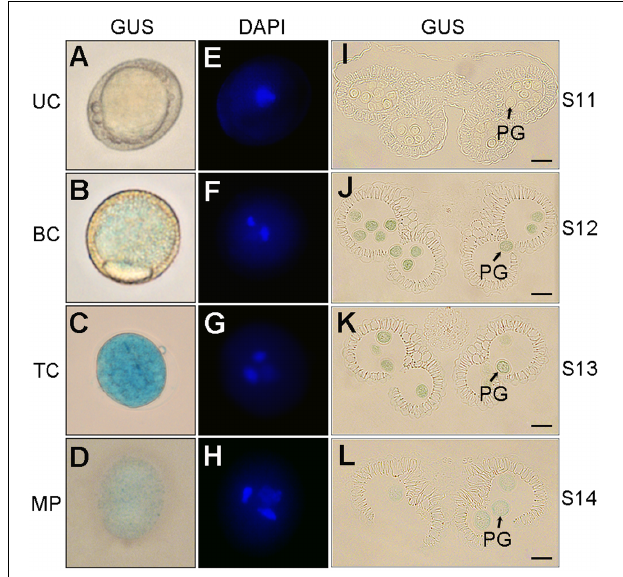
FIGURE 3 | GUS expression driven by p158 in developing pollen. (A–H) DAPI staining of developing pollen in p158 transgenic Arabidopsis plants. UC, unicellular microspores; BC, bicellular pollen; TC, immature tricellular pollen; MP, mature pollen. (I–L) Transverse section of developing anthers of p158 transgenic Arabidopsis plant. PG, pollen grain. Scale bars = 20 µ